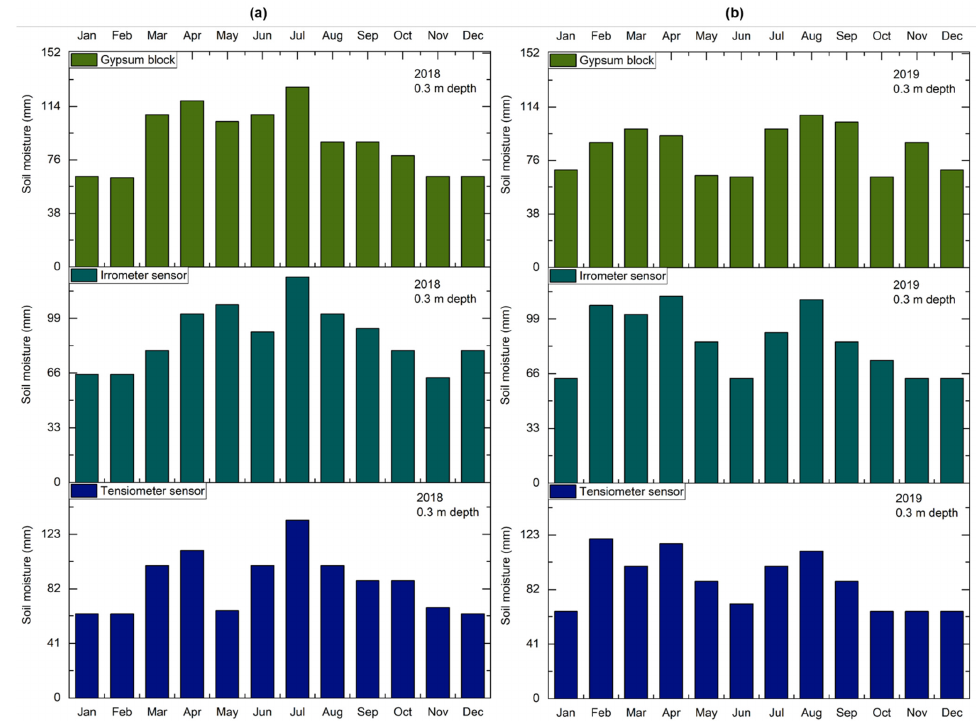
Figure 9. Timeline graphs of soil moisture distribution profiles to schedule irrigation in ( a ) 2018 at 0.3 m depth and ( b ) 2019 at 0.3 m depth by different soil moisture sensors. According to the results, the irrometer sensor scheduled irrigation with a smaller number of irrigation events. Table 5 shows the amount of supplemental irrigation, num- ber of irrigations, and water-saving potential using the different soil moisture sensors as compared to conventional farmer practice. The irrometer sensors were found to be more accurate, as they saved about 9% of irrigation water by skipping one irrigation event as compared to the tensiometer sensors and gypsum blocks without disturbing olive productivity. In farmer practice there were no soil moisture sensors for the irrigation scheduling and the farmer triggered irrigation based only on feeling the soil. However, olives irrigated through soil moisture sensors were given3 and 4 irrigations less with 17 and 22% of water savings through supplemental irrigations in 2018 and 2019, respective- ly, in the case of tensiometer sensors and gypsum blocks, while the irrometer sensors saved about 25% of water in 2019.